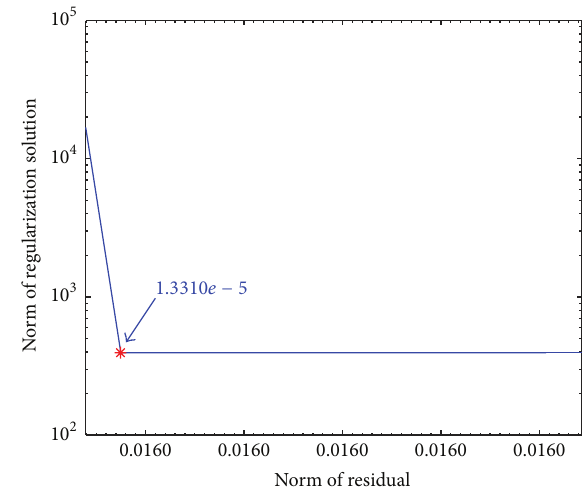
Figure 2: QF for AM load identification of SISO system.